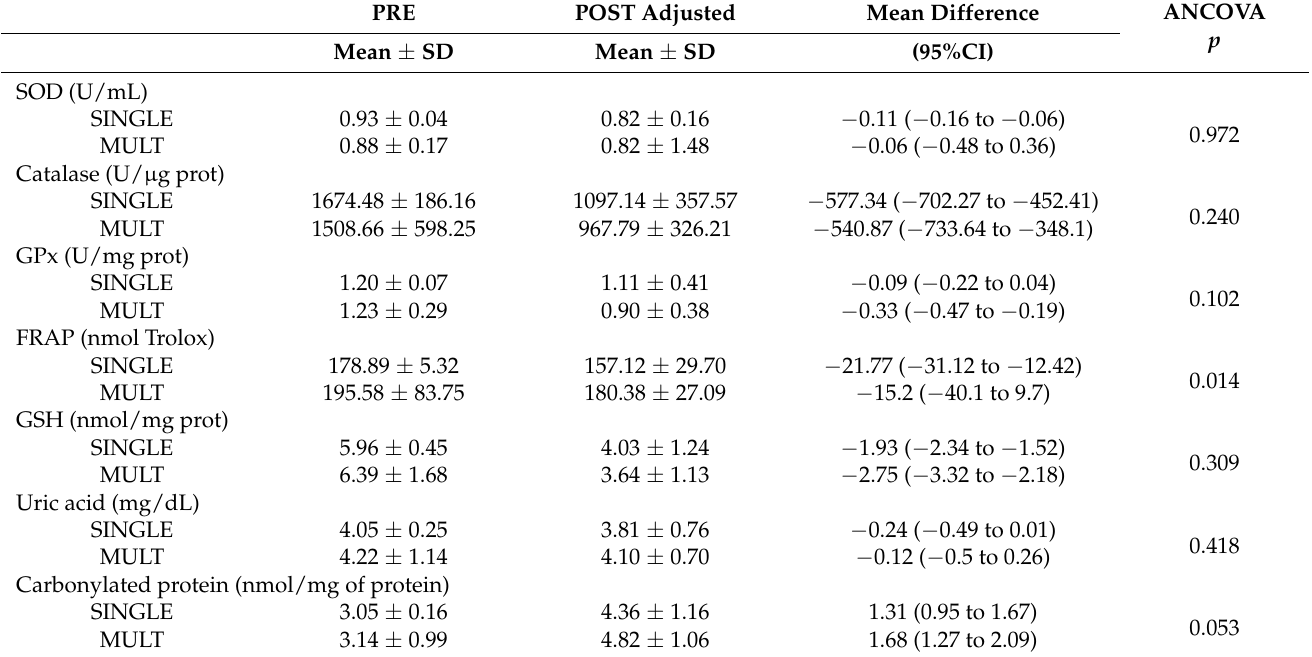
Table 3. Plasma redox status in SINGLE ( n = 20) and MULT ( n = 24) before and after 12 weeks of Mat Pilates training.